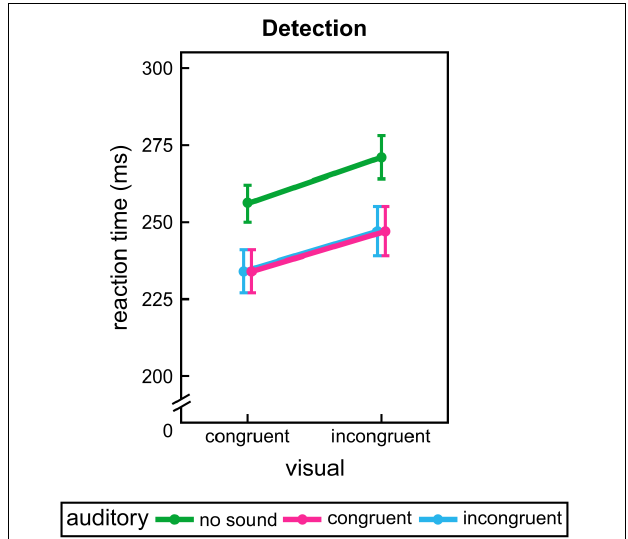
FIGURE 3 | Group mean results of experiment 1. Reaction times for each visual path and sound conditions during detection. Error bars show the standard error of the mean. Points are offset horizontally so that all error bars are visible.